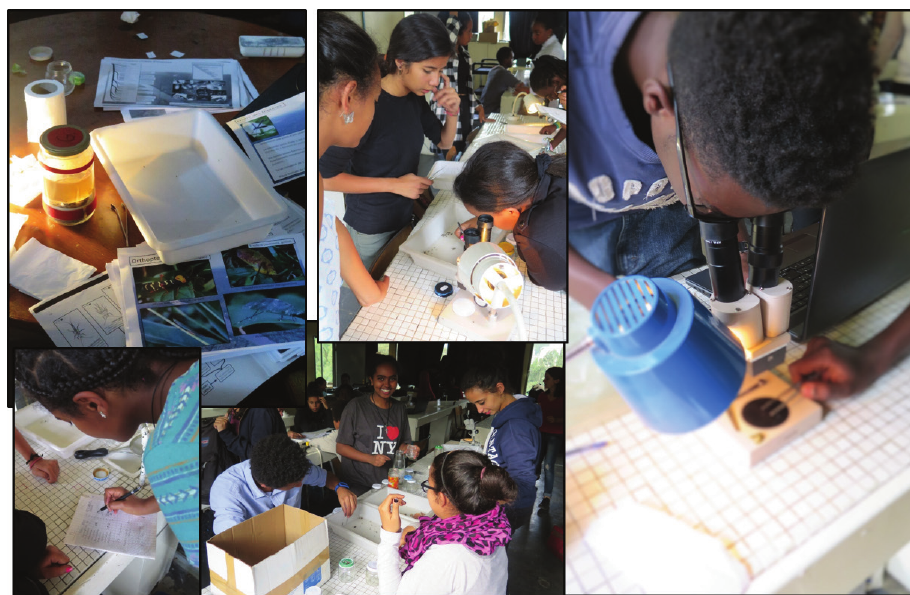
Figure 4. Pictures of the laboratory activities including the organisation, sorting and counting of the collected specimen using a systematic procedure under microscope